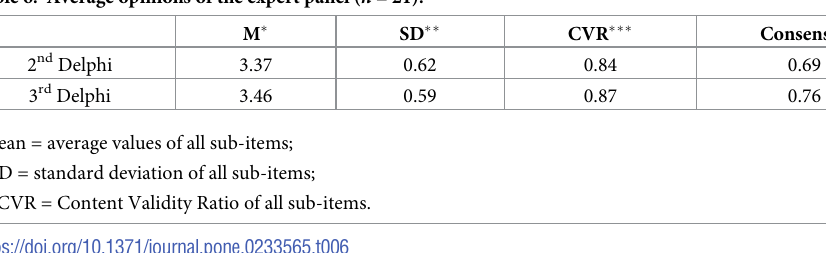
Table 6. Average opinions of the expert panel ( n =